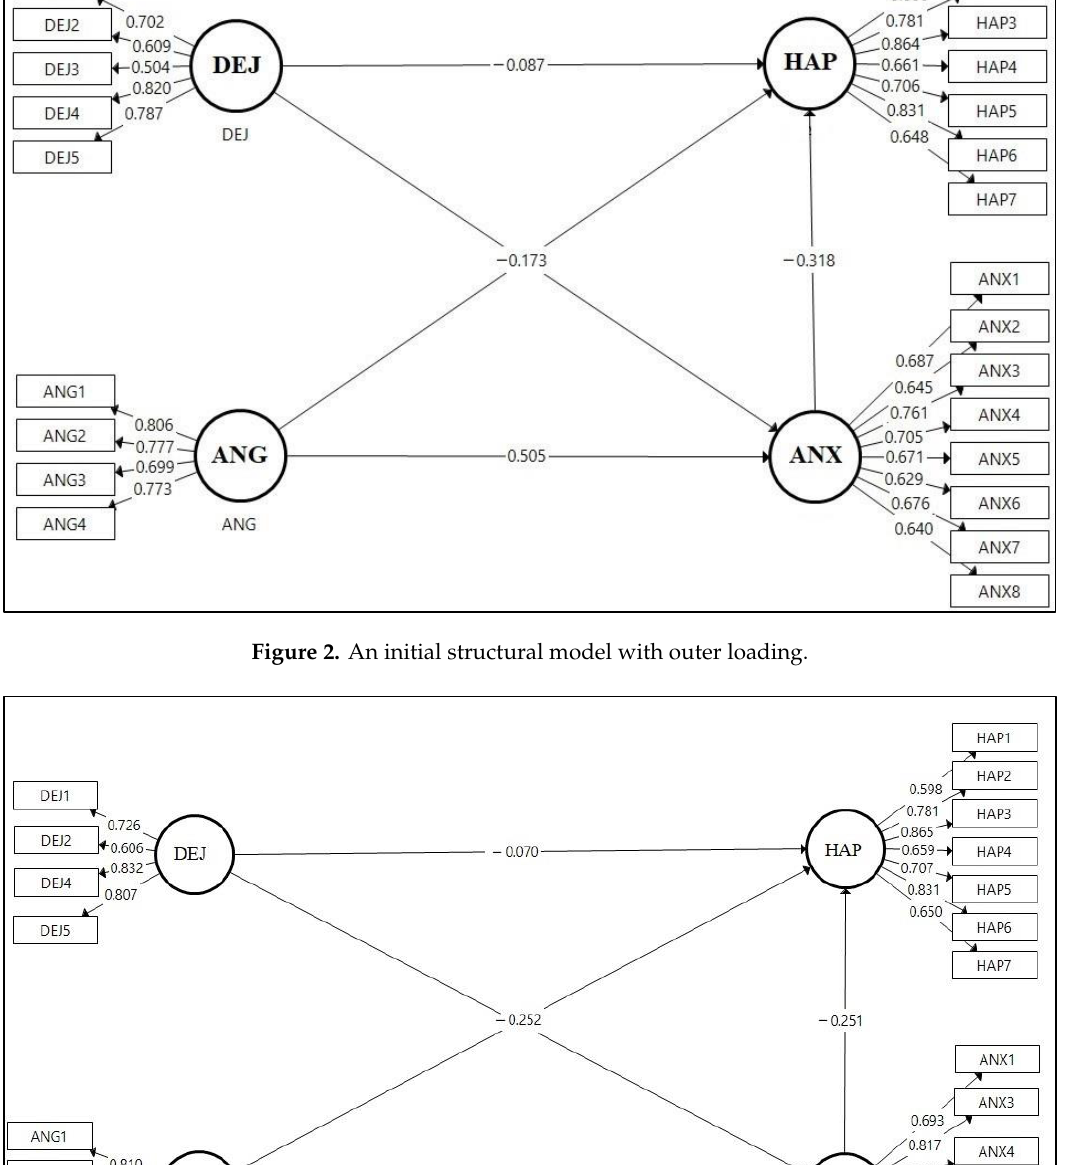
Table 4. Reliability and convergent validity: comparison of the initial and final structural model.